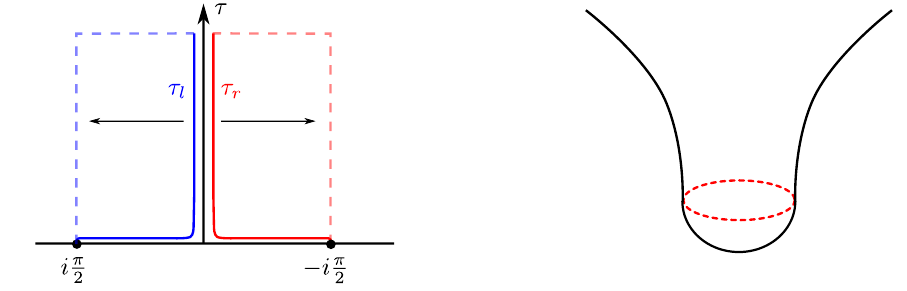
Figure 21 . Left : solid lines, the HH contours for τ l and τ r , real part of τ grows upwards; dashed lines, contours after analytic continuation to EAdS. The horizontal part of dashed lines does not contribute at late times. Right : geometrical picture corresponding to the HH